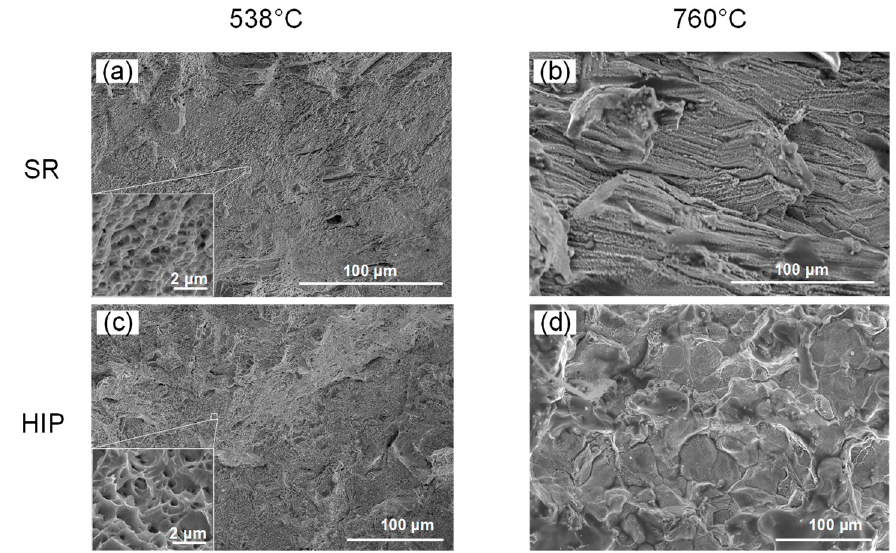
Figure 6. Fracture surfaces of the ( a , b ) SR (horizontal) and ( c , d ) HIP specimens, tensile-tested at ( a , c ) 538 °C and ( b , d ) 760 °C.